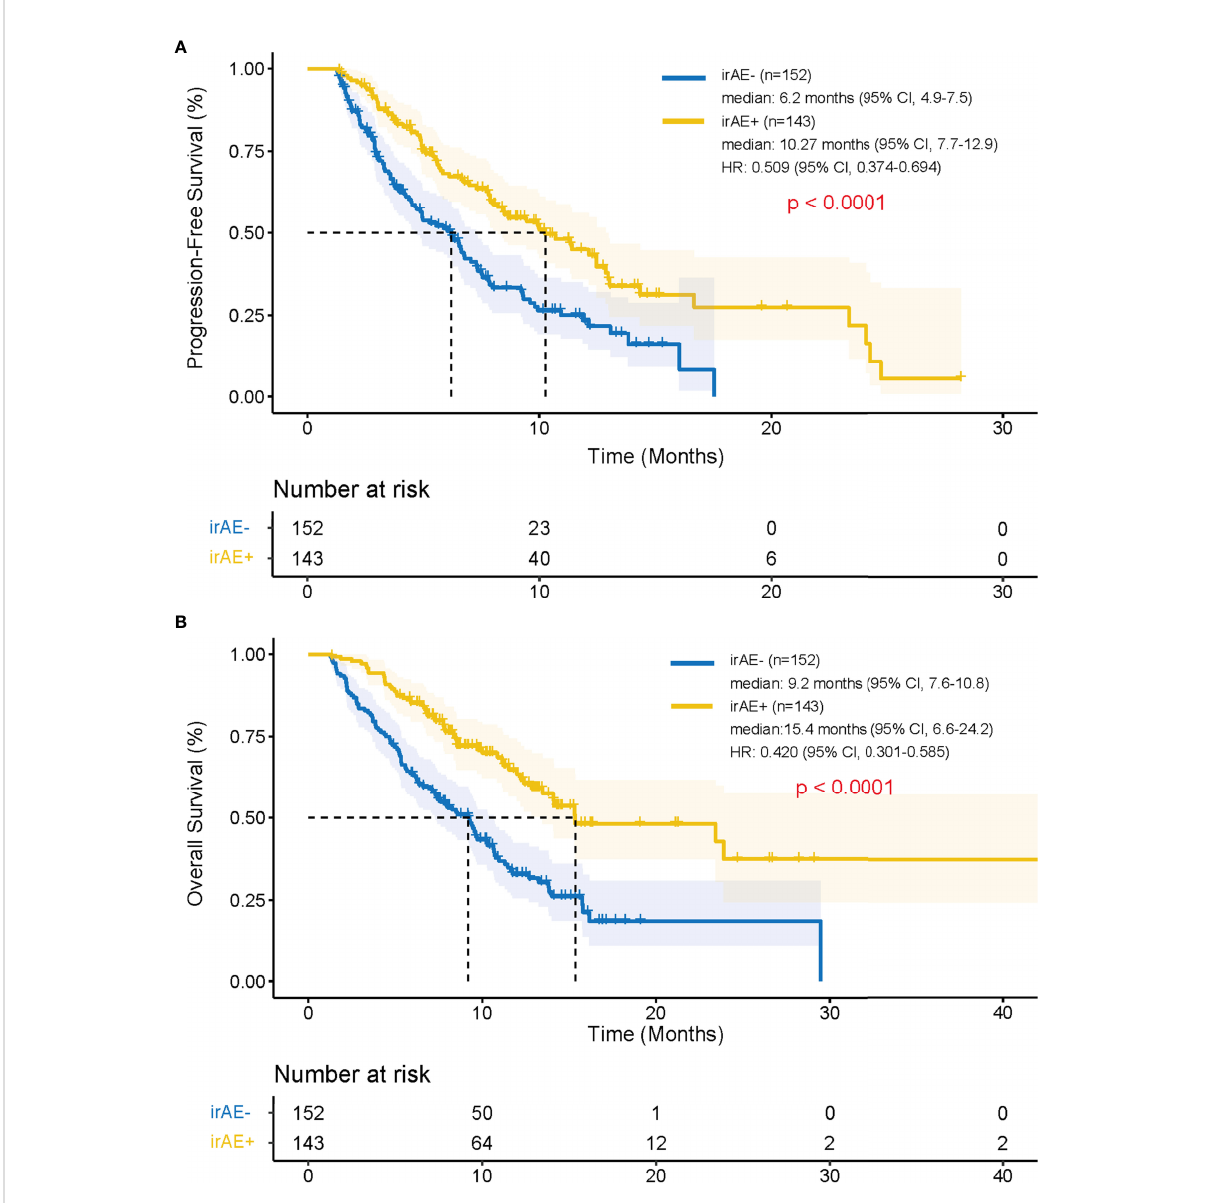
FIGURE 2 Progression-free survival and overall survival after the treatment of PD-1 inhibitors depending on the development of irAEs using Kaplan-Meier method. Kaplan – Meier curves for (A) progression-free survival and (B) overall survival in patients with or without irAE. irAEs, immune-related adverse events; HR, hazard ratio; CI, con fi dence